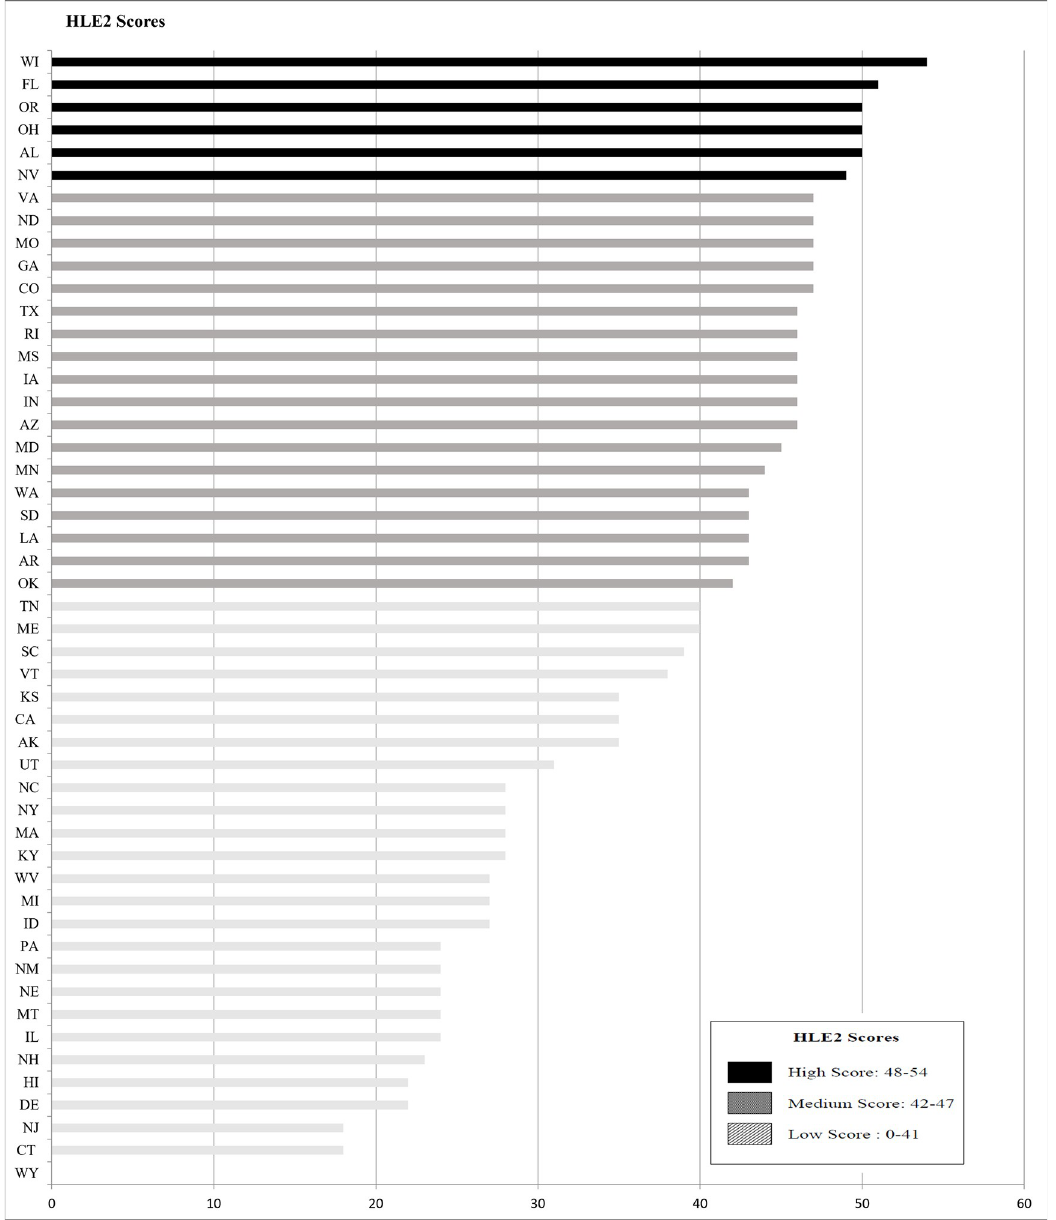
Fig 2. State health department (N = 50) HLE2 a scores assessing website content related to community water fluoridation, August 2019. a The HLE2 Score is an indicator of how easy or difficult it is to navigate a website and find